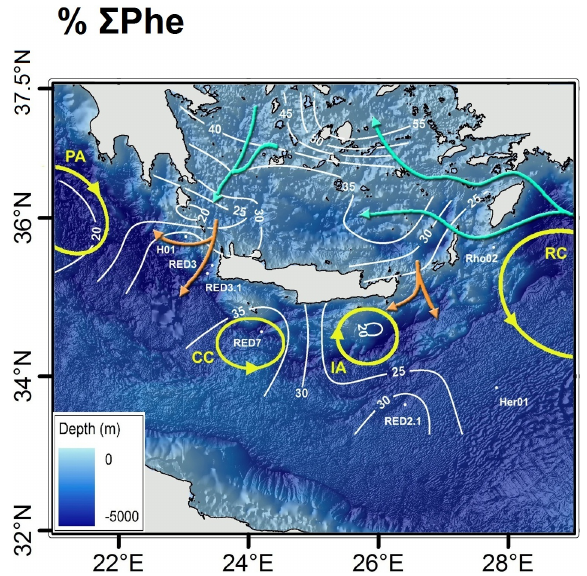
Fig. 10. Spatial contour map of % P Phe contribution in the central Aegean Sea, Cretan Sea (southern Aegean Sea), western Cretan– Antikythera Straits and northwestern Levantine surface sediments. Data regarding central Aegean Sea sediments are reported by Hatzianestis and Sklivagou (2001), data regarding Cretan Sea sedi- ments are a combination of data reported in this study and data re- ported by Hatzianestis and Sklivagou (2001), while data regarding northwestern Levantine sediments are reported in this study. P Phe sum includes Phe, C 1 -Phe and C 2 -Phe, while% P Phe is calculated on the basis of 15 PAH compounds common for Hatzianestis and Sklivagou (2001) and this study, i.e., Phe, C 1 -Phe, C 2 -Phe, Anth, Flth, Pyr, BaA, Chry, BFlths, BeP, BaP, Per, IndP, BgP and DBA (PAH abbreviations are presented in Fig. 2); RC: Rhodes cyclone; IA: Ierapetra anticyclone; CC: Cretan cyclone; PA: Pelops anticy- clone; orange lines: Cretan intermediate/deep-waters outflow; cyan lines: Aegean Sea surface waters pathways. Bathymetric data were produced using the GEBCO Digital Atlas (IOC, IHO and BODC,